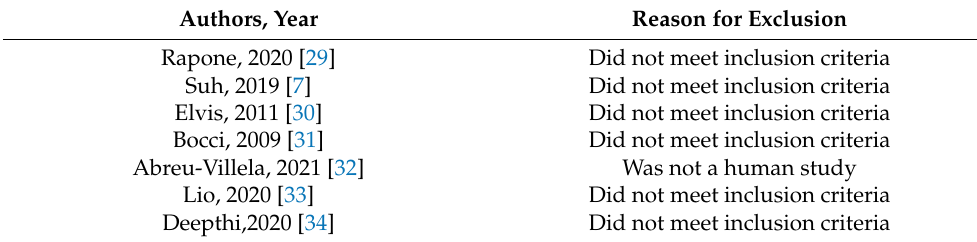
Table 1. Studies excluded along with reasons for